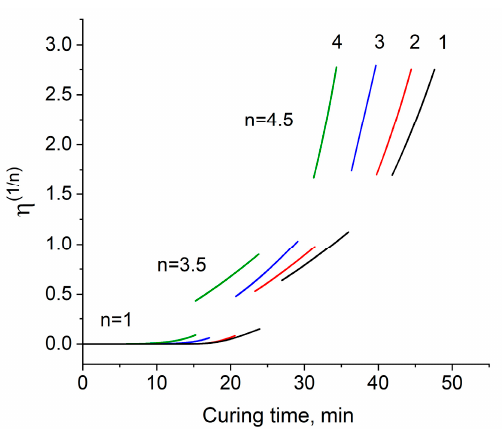
Figure 4. The dependence of viscosity on curing time in the coordinates of the modified Malkin– Kulichikhin equation at a temperature of 170 °C for formulations 1–4.